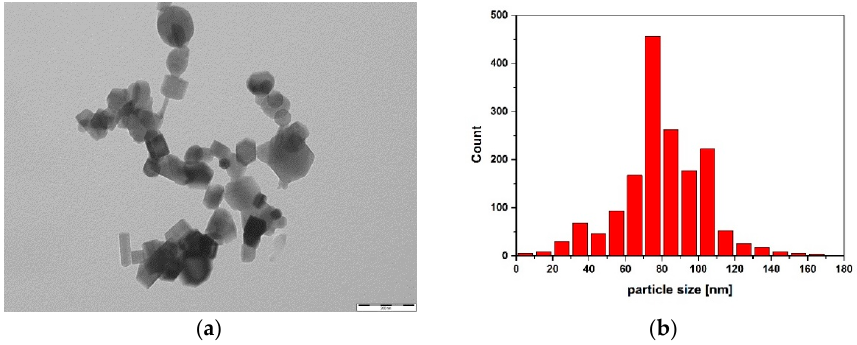
Figure 2. ( a ) Typical AlN nanoparticles (scale bar: 200 nm) and ( b ) their particle size distribution.